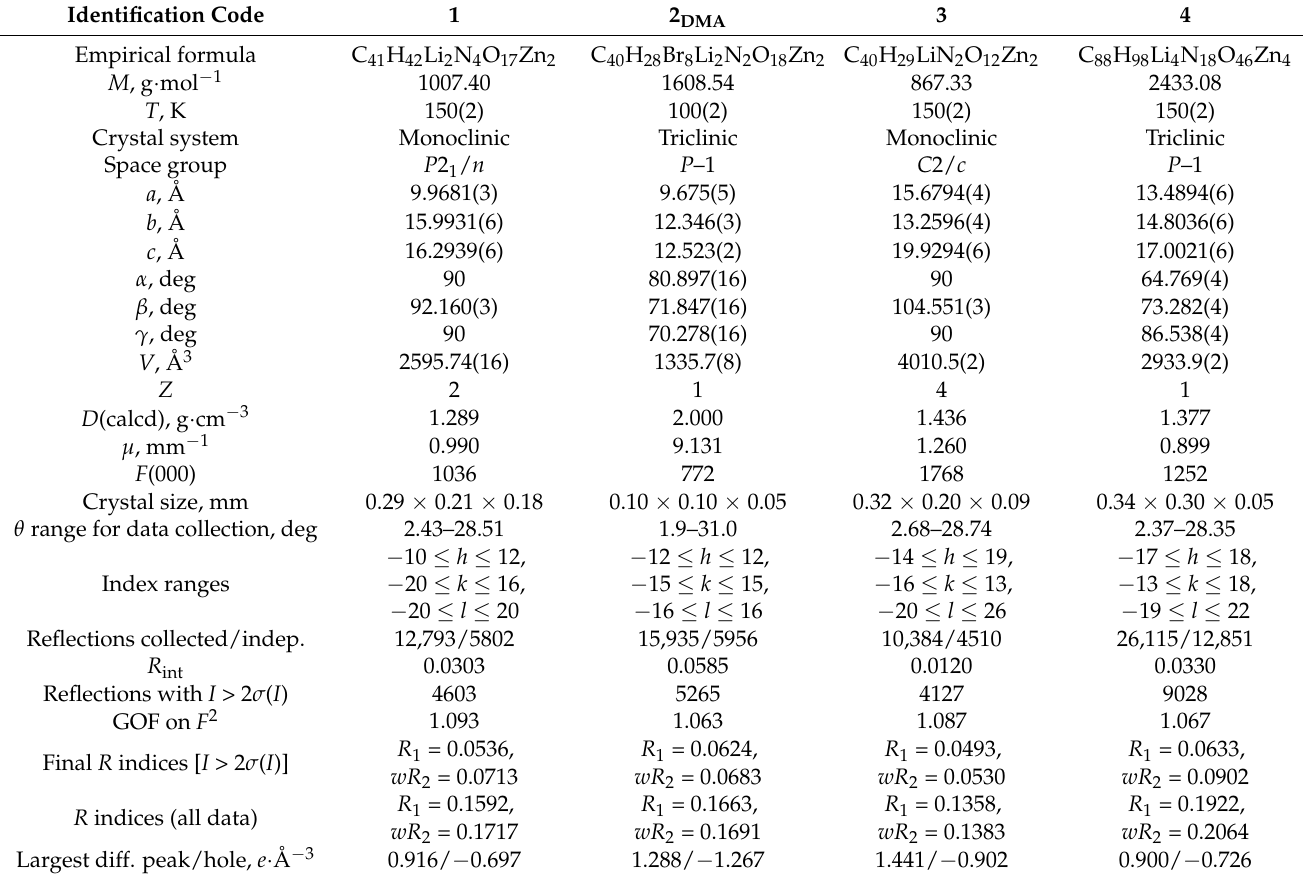
Table 1. Crystal data and structure refinement for compounds 1 – 4 .